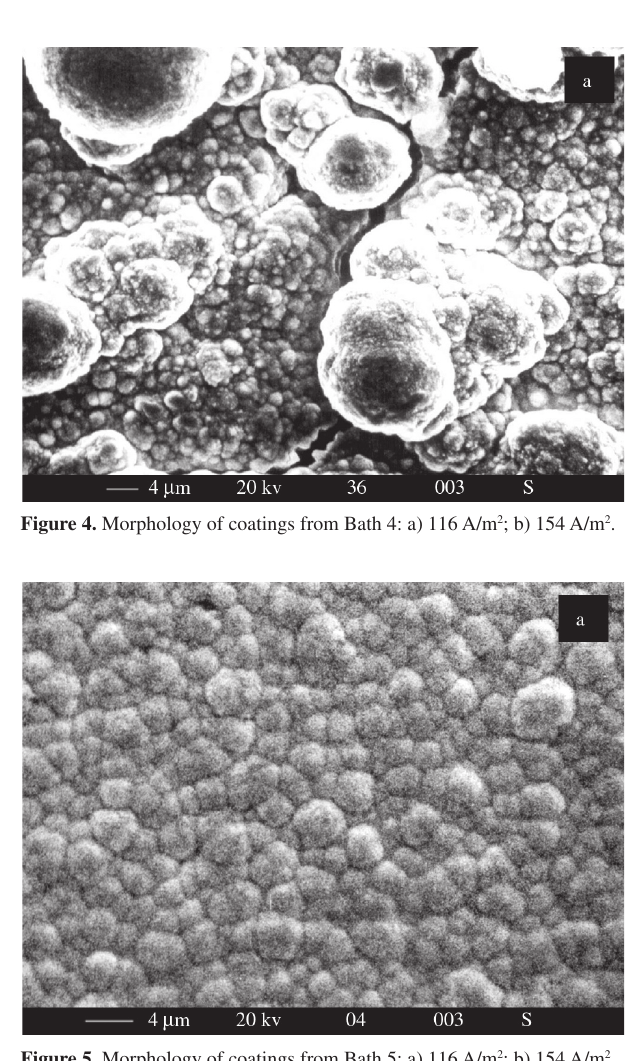
formation of a more stable copper complex in the presence of H ion 14,24 . The coatings produced at a higher current density (153 A/m 2 ) presented some clusters and small cracks (Figure 2b). Nonetheless, the